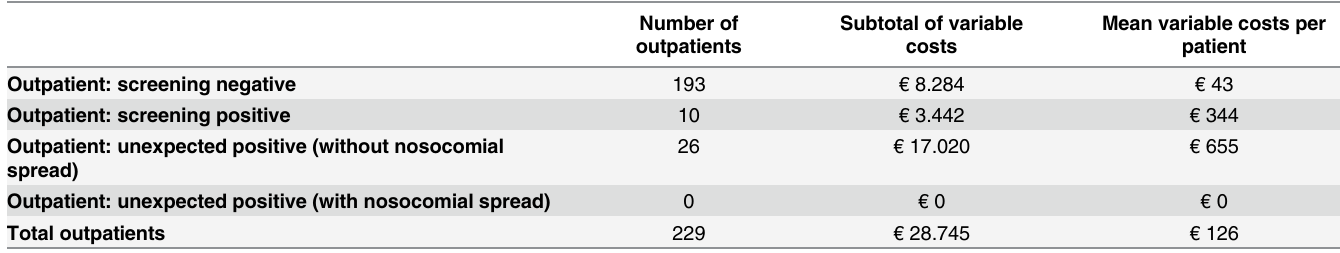
Table 6. Costs per category of outpatients.